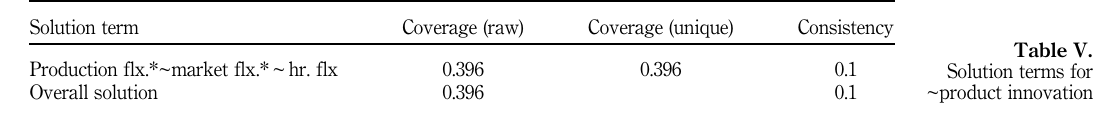
Table V. Solution terms